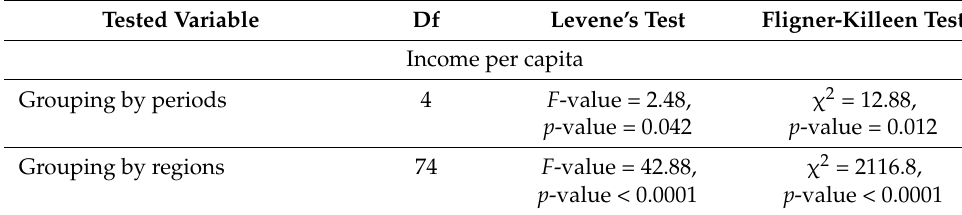
Table 2. Results of variance homogeneity